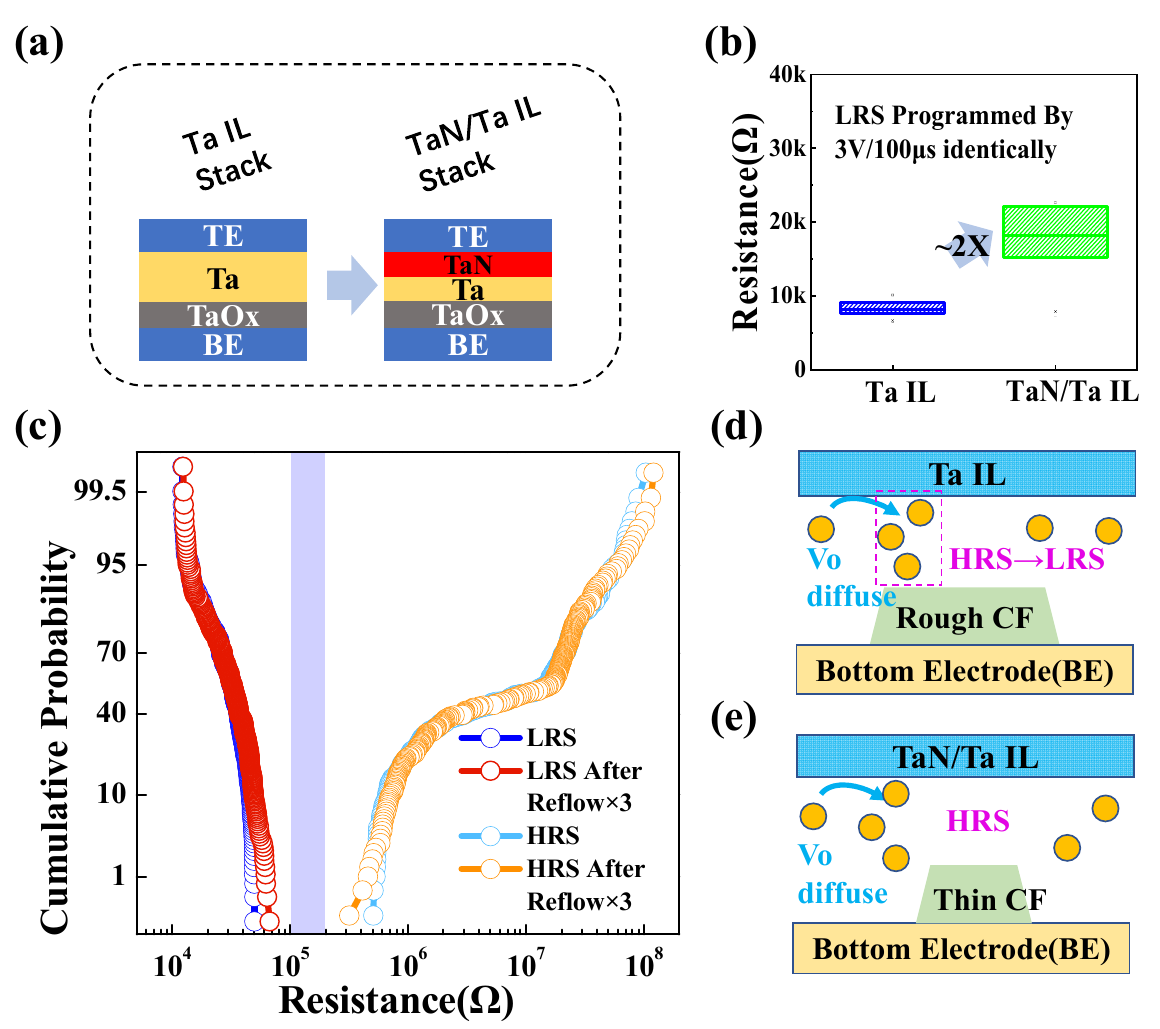
Figure 3. ( a ) The schematic diagram of the RRAM stack with an additional thin TaN layer to optimize retention behavior. ( b ) A comparison of LRS for the two structures described in ( a ). ( c ) The HRS and LRS distributions before and after the reflow process 3 times at 260 °C for TaN–Ta IL devices. The HRS retention failure scenarios of the structures with ( d ) the Ta IL and ( e ) the TaN–Ta IL.